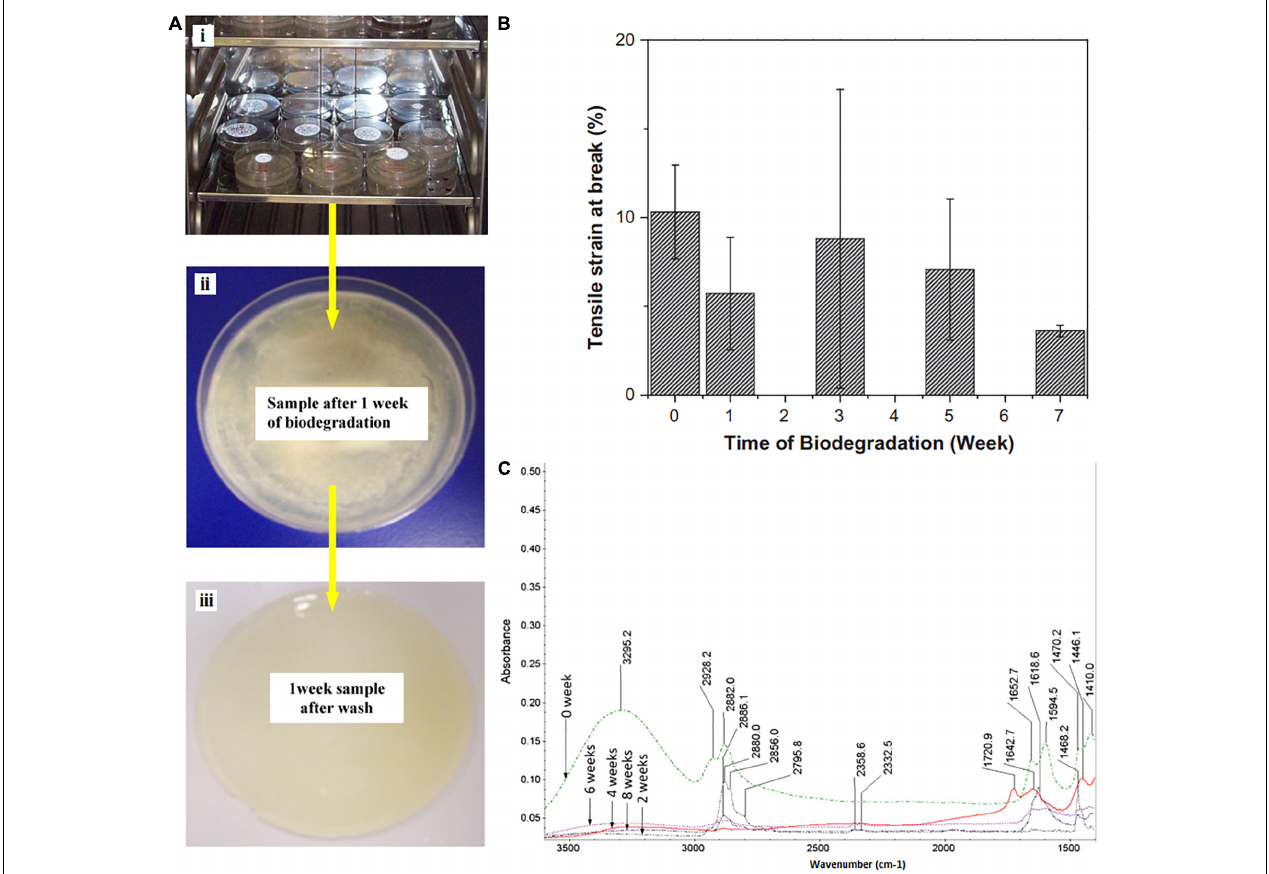
FIGURE 3 | (A) Optical view for biodegradation behavior of PVP–CMC films during the biodegradation process in liquid kept inside an incubator at 30 ◦ C (i) plates with films in liquid environment inside, (ii) an image of microbial growth on film, and (iii) an image of the film after removing the biodegradation conditions. (B) Tensile strain (at break) of dried PVP–CMC films before and after biodegradation. (C) FTIR of PVP–CMC films in dry state, before after biodegradation [reproduced with permission from Roy et al.